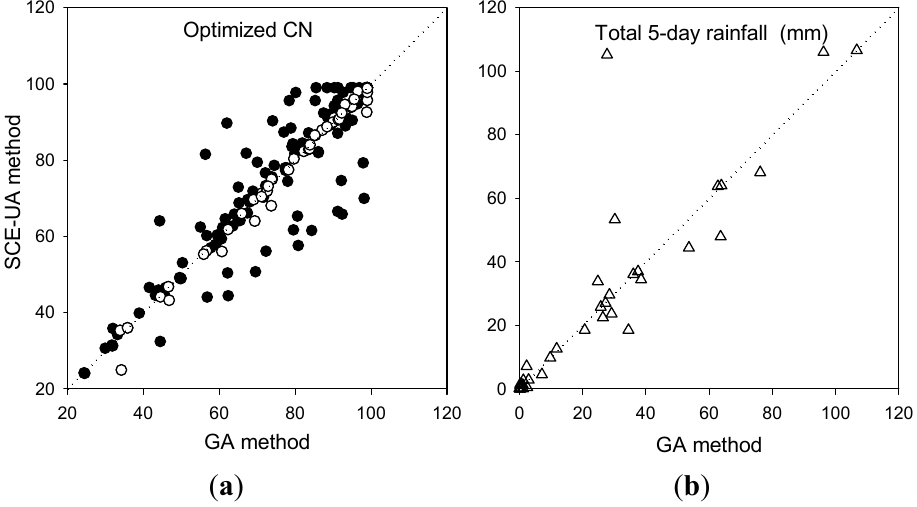
Figure 12. 1:1 scatter plots of optimized CN and total 5-day rainfall for AMC adjustment. The filled and blank circles represent the calibrated CN values for all land uses and for the dominant land use, respectively, found in each watershed. ( a ) Optimized CN values; ( b ) Range of 5-day rainfall for AMC adjustment